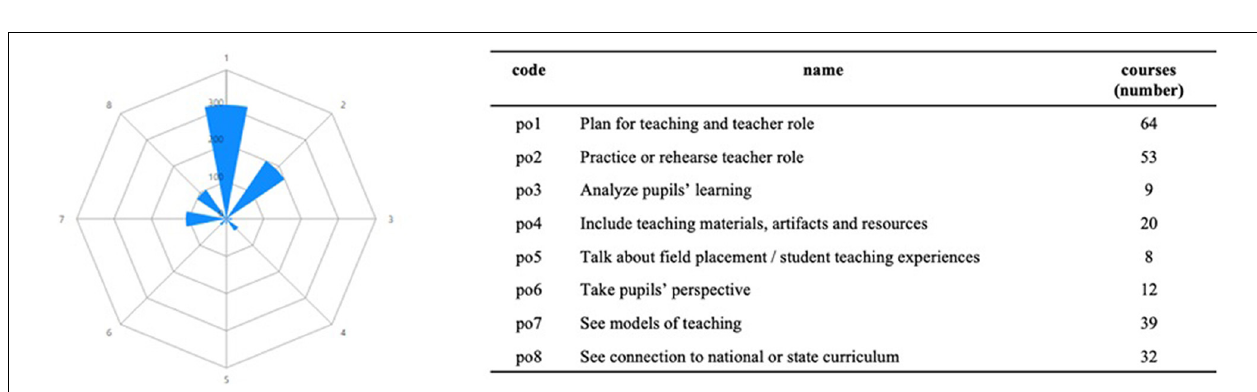
FIGURE 3 | Frequency of each practice opportunity in learning activities planned to be performed during on-campus coursework.